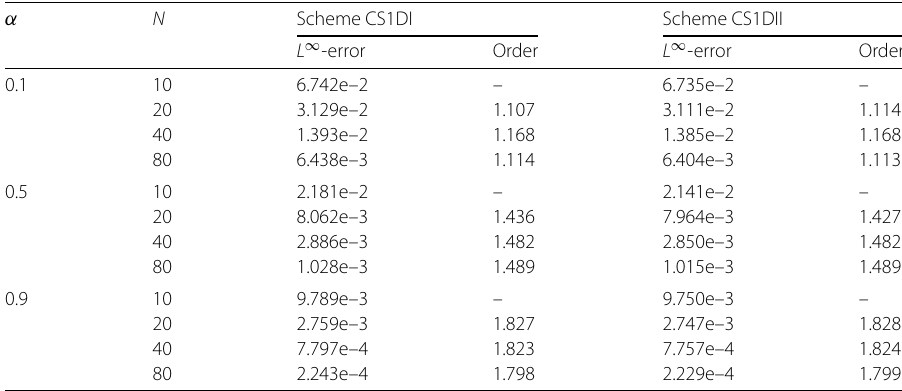
Table 6 Numerical comparison results of schemes CS2DI and CS2DII for Example 3, at T = 1 with M = 100 and different N and α